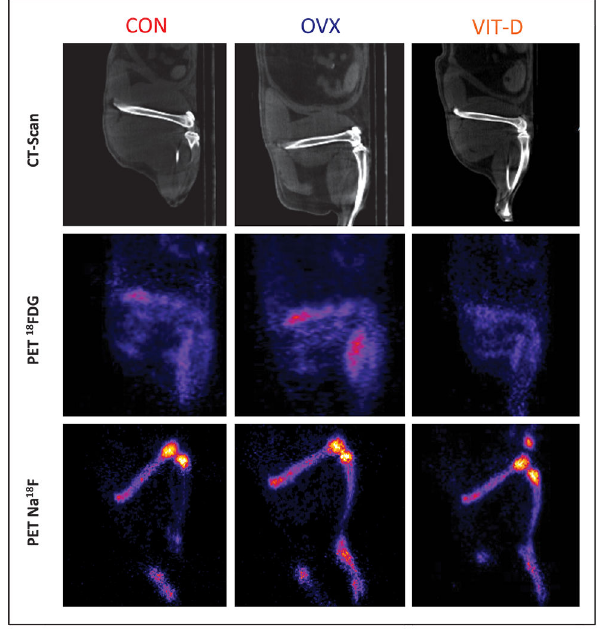
Figure 3. CT, PET 18 FDG and PET Na 18 F images from representative animals from CON, OVX and VIT-D groups.